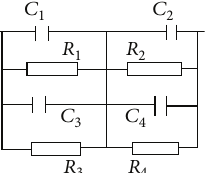
Table 1: Chemical composition of hemp, flax, jute, and cotton fibers.